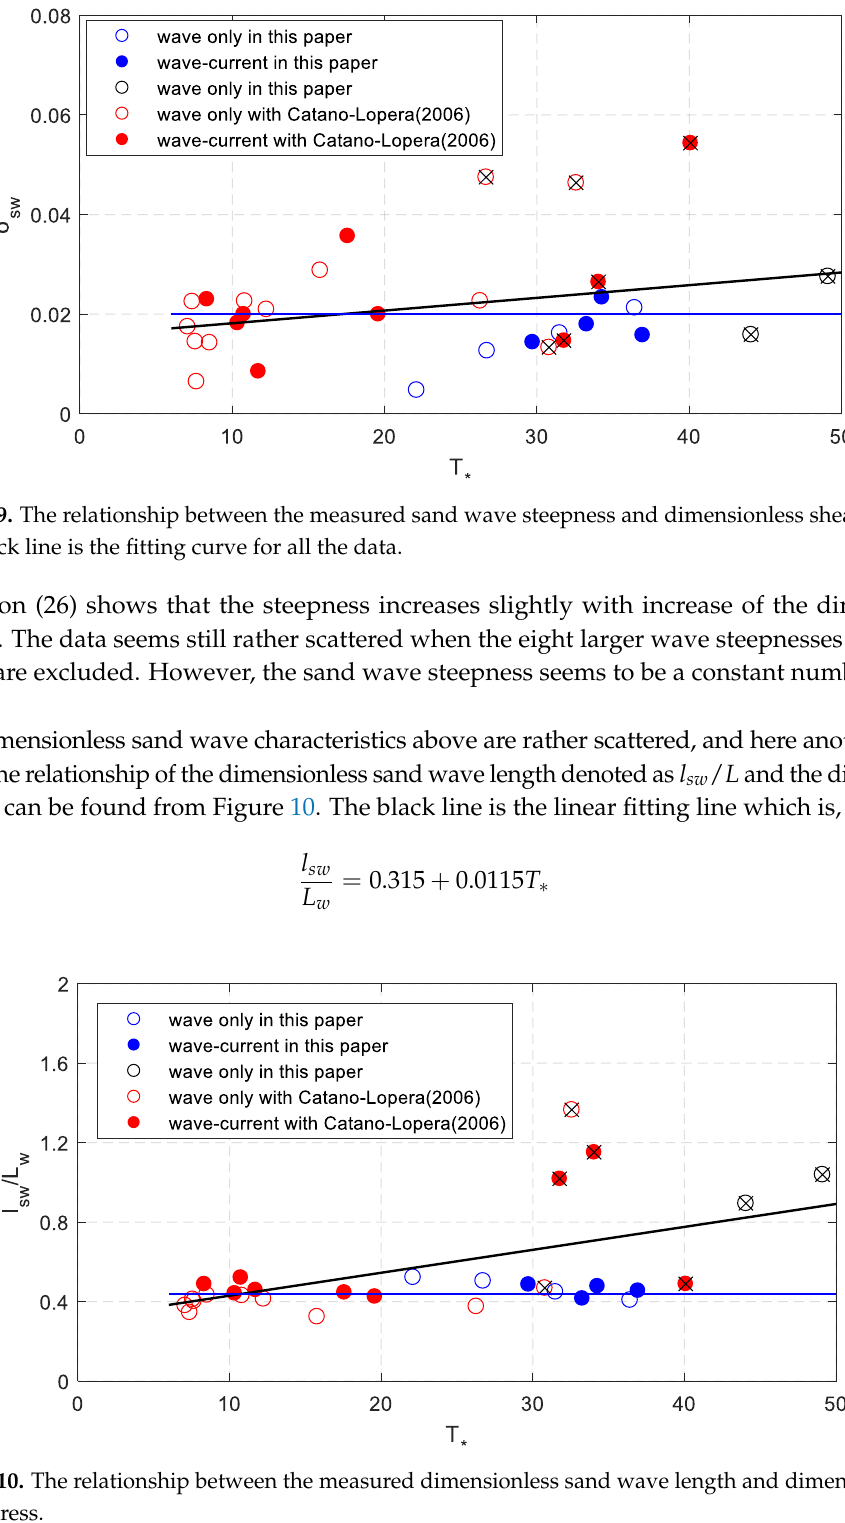
Figure 8. The relationship between the measured dimensionless sand wave length and dimensionless shear stress.